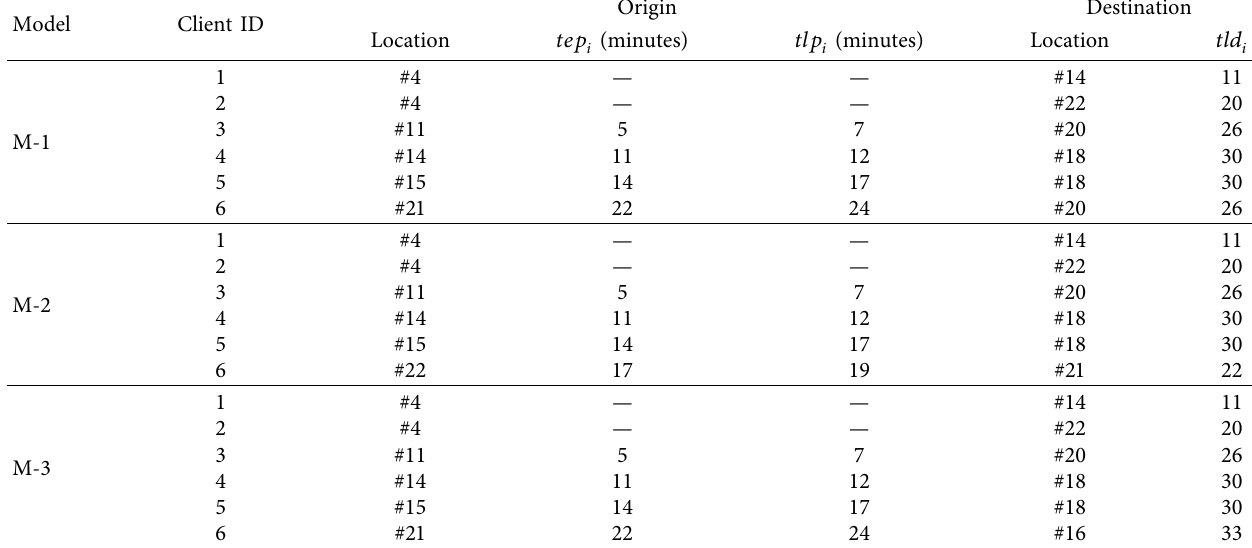
Table 1: CB request with given OD location and time